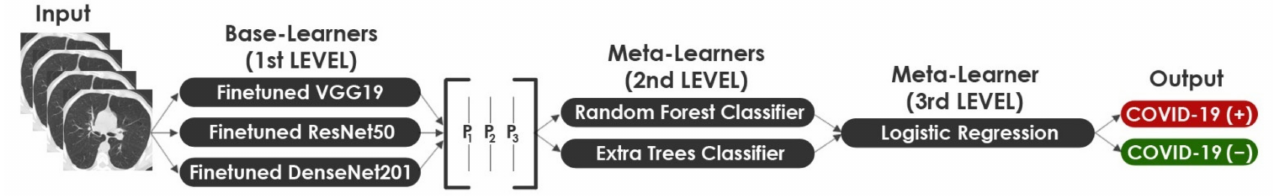
Figure 15. Representation of the 3-Levels Stacking approach.